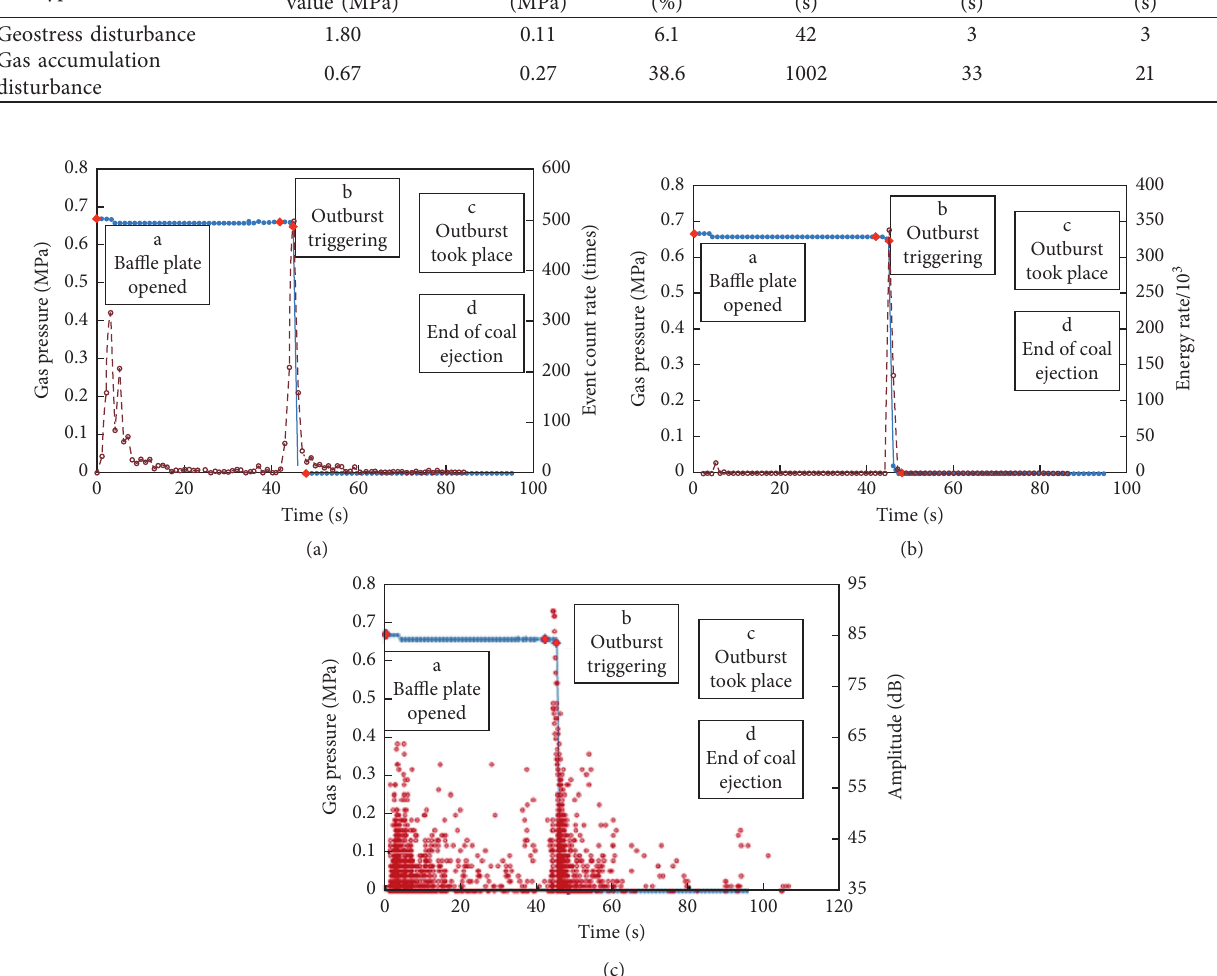
Figure 10: AE characteristics of the delay outburst under the geostress disturbance. (a) AE event count rate variation; (b) AE energy rate variation; (c) AE amplitude